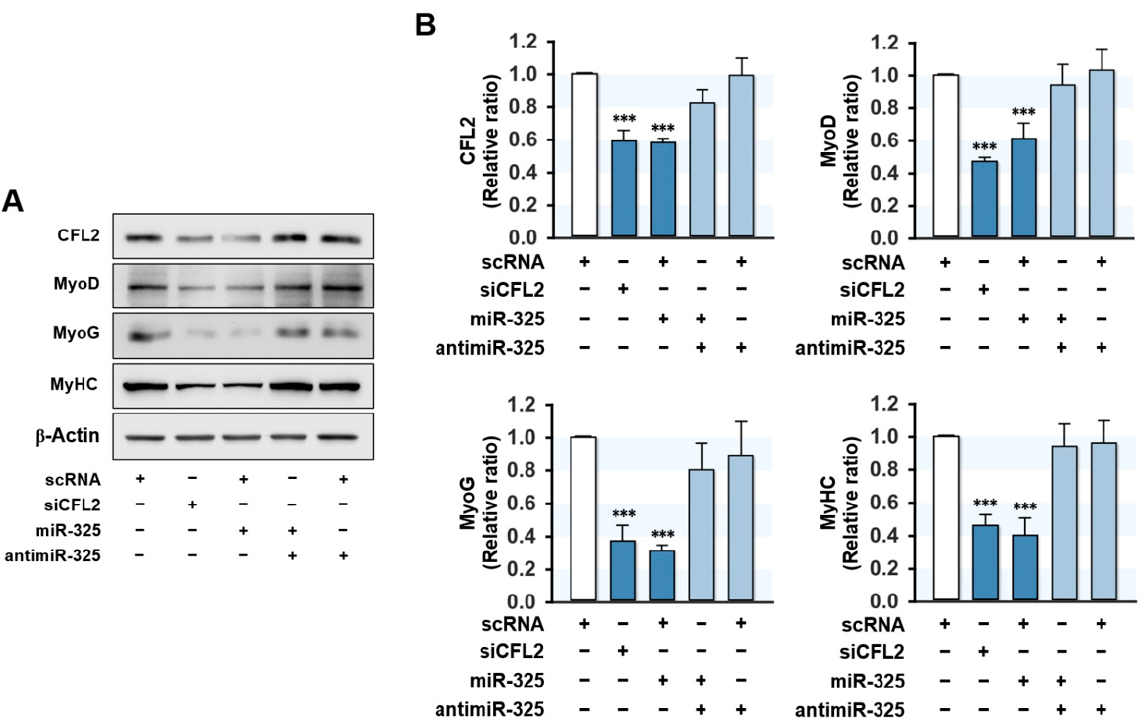
Figure 5. MiR-325-3p suppressed myogenic factors expressions. C2C12 cells were transfected with 200 nM of scRNA, siCFL2, miR-325-3p mimic (miR-325), or antimiR-325-3p (antimiR-325) and differentiated for three days. ( A ) Representative immunoblots of CFL2, MyoD, MyoG, and MyHC levels. ( B ) Quantitative analysis of immunoblots with antibodies for myogenic factors (MyoD, MyoG, and MyHC) and CFL2. Intensities were normalized versus β -actin. All results are presented as the means ± SEMs ( n > 3), and levels of significance are presented as ***, p < 0.001 vs. scRNA controls.